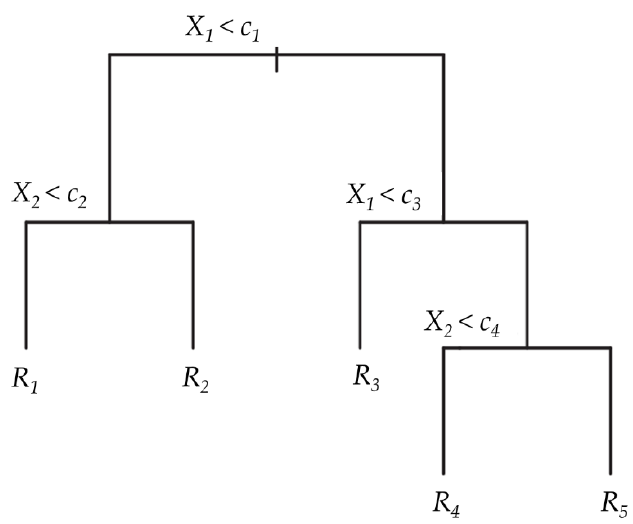
Figure 2. A single decision tree.